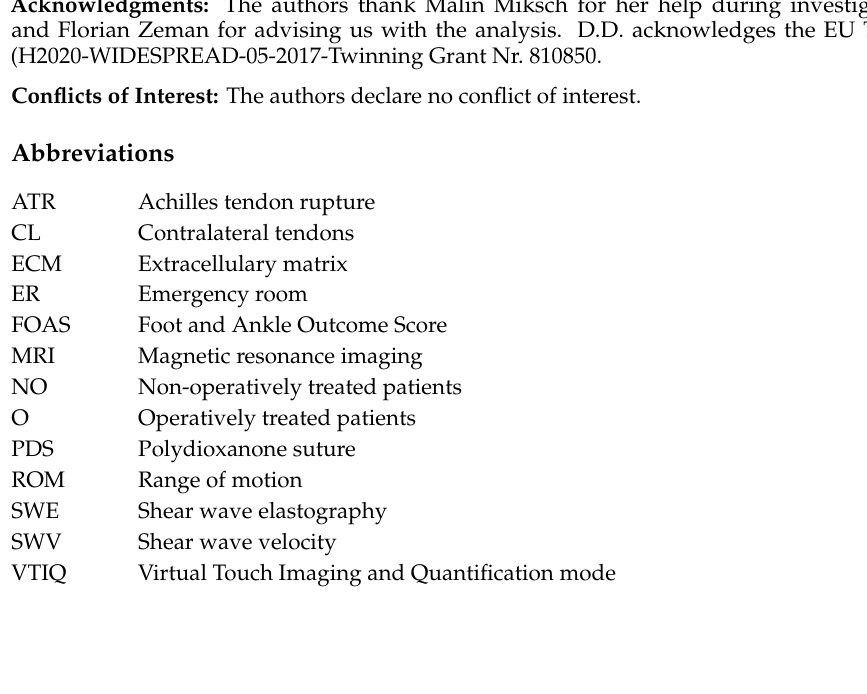
Supplementary Materials: Supplementary Materials (Overview of the included patients, their demographic data, relevant comorbidities, SWE results and elastographic curves) can be found at http: // www.mdpi.com / 1422-0067 / 21 / 10 / 3427 /